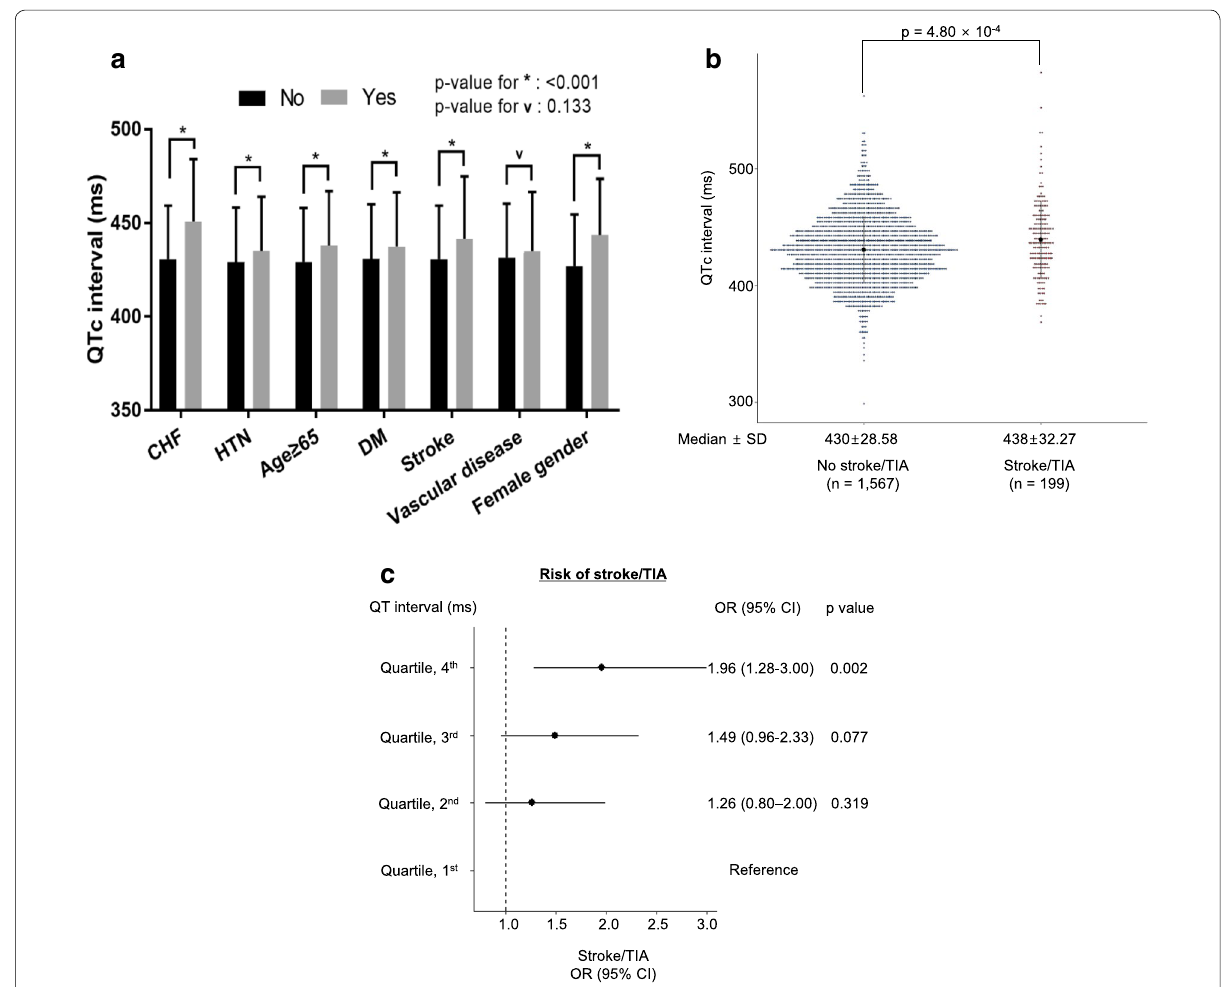
Fig. 1 a Comparison of the QTc intervals with respect to the clinical risk factors of the CHA 2 DS 2 ‑VASc score was expressed as bar graphs. Vascular disease includes prior a myocardial infarction, peripheral artery disease, and aortic plaque. b , c Observational association between the QTc interval and a stroke/TIA. b Association of the QTc interval according to that with or without a stroke/TIA. c Association of a stroke/TIA based on the quartile value of the QTc interval